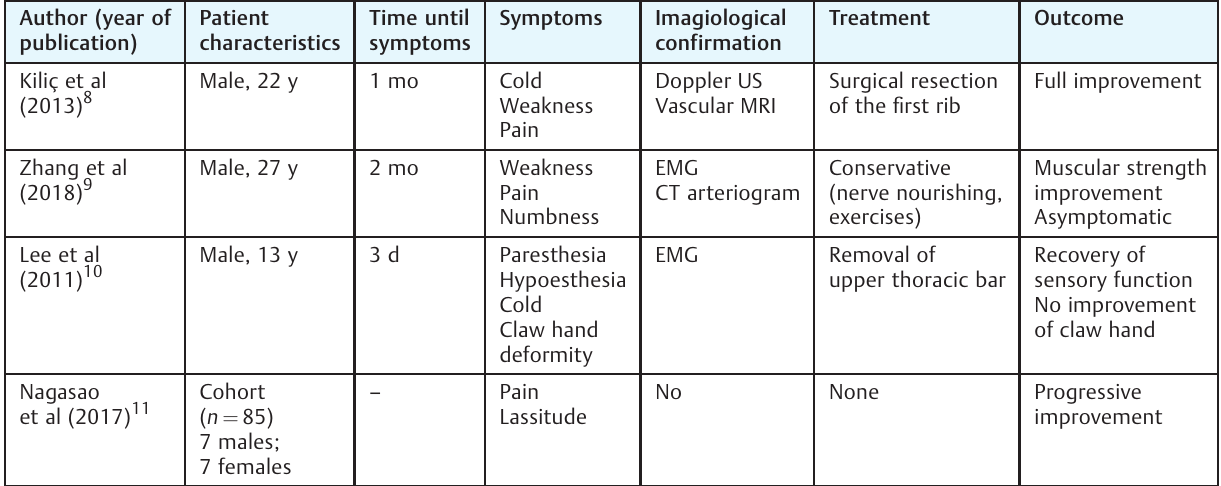
Table 1 Review of literature on TOS post-Nuss procedure Author (year of publication)